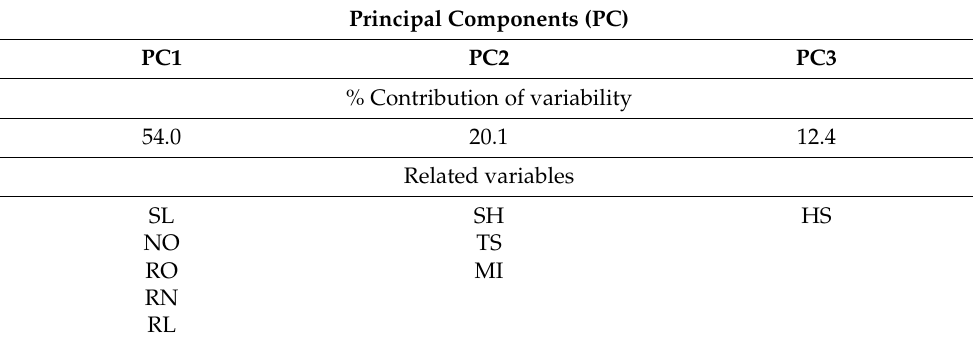
Table 3. Results of principal components analysis (PCA) of variation on total response data.